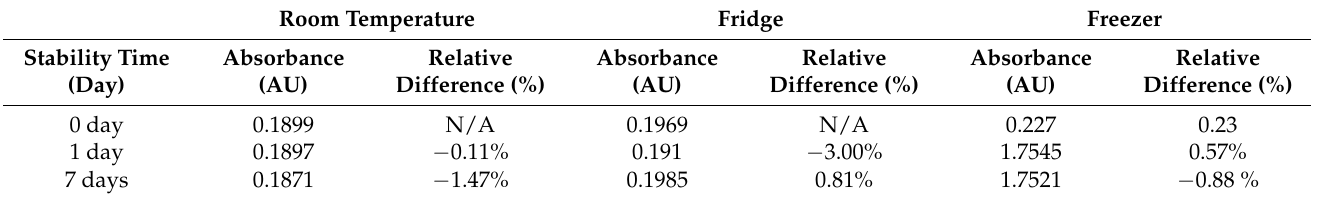
Table 10. Stability of the standard solution of 6.25 µ g/mL stored at different temperatures: room temperature, fridge, and freezer, as analyzed by absorption spectroscopy (spectrophotometry).